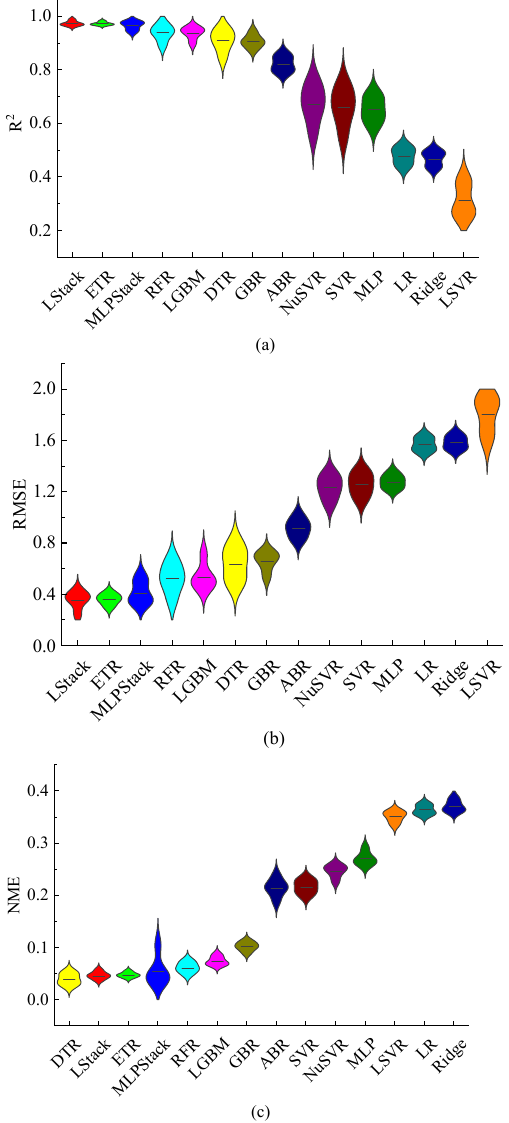
Figure 7. ( a ) R 2 for the 14 different models in predicting feed intake rate; ( b ) RMSE (unit: g/min) for the 14 different models in predicting feed intake rate; ( c ) NME (dimensionless) for the 14 different models in predicting feed intake